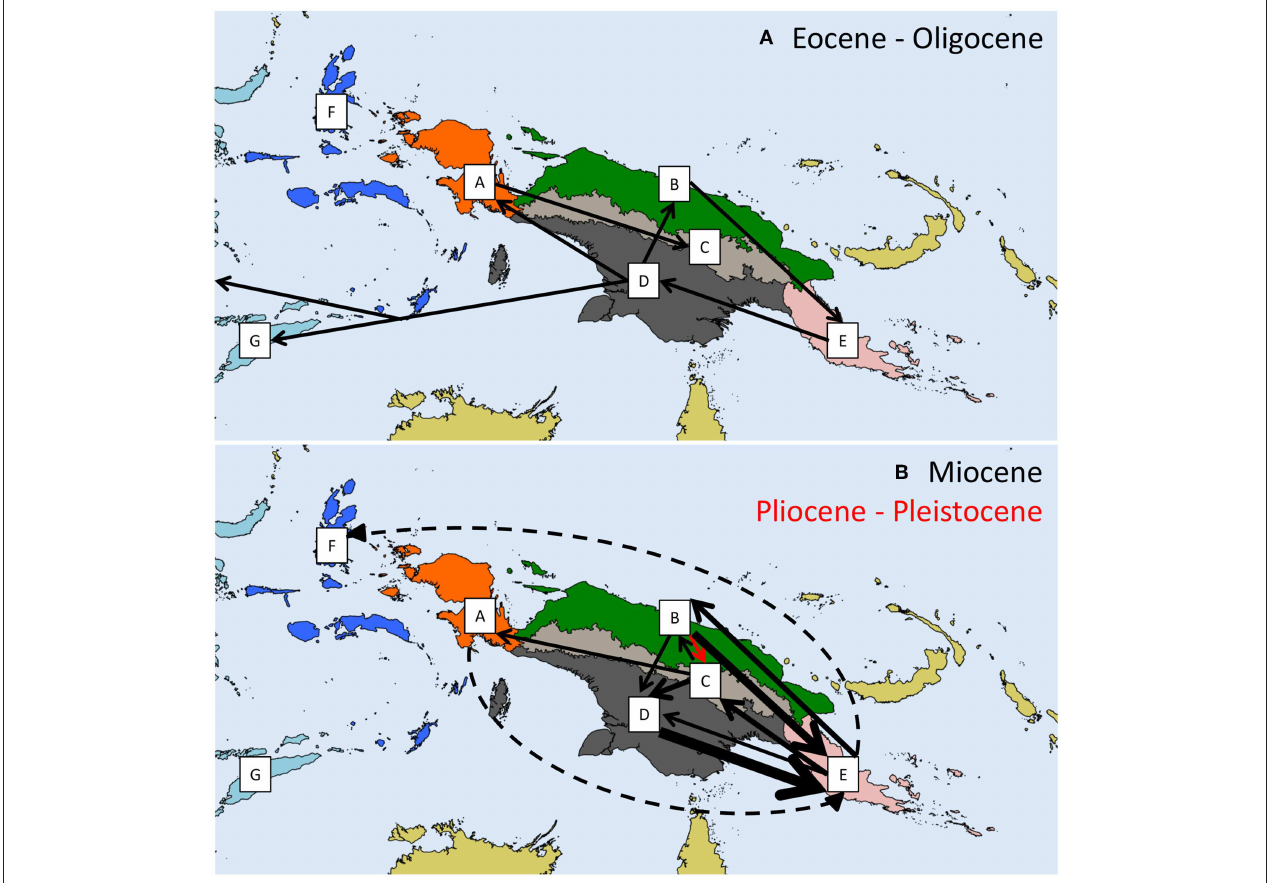
FIGURE 2 | Biogeographic dispersal events inferred from the Bayesian Binary MCMC analysis Yu et al. (2015) for each of the three considered time slices: (A) Eocene-Oligocene; (B) Miocene and Pliocene-Pleistocene. Biogeographic areas correspond to freshwater ecoregions of New Guinea ( Abell et al., 2008) as in Figure 1 . Dashed arrows represent dispersal from geographically distant areas, which may involve stepping stone dispersal through in-between areas. The width of an arrow is proportional to the number of dispersal events (ranging between 1 and 8